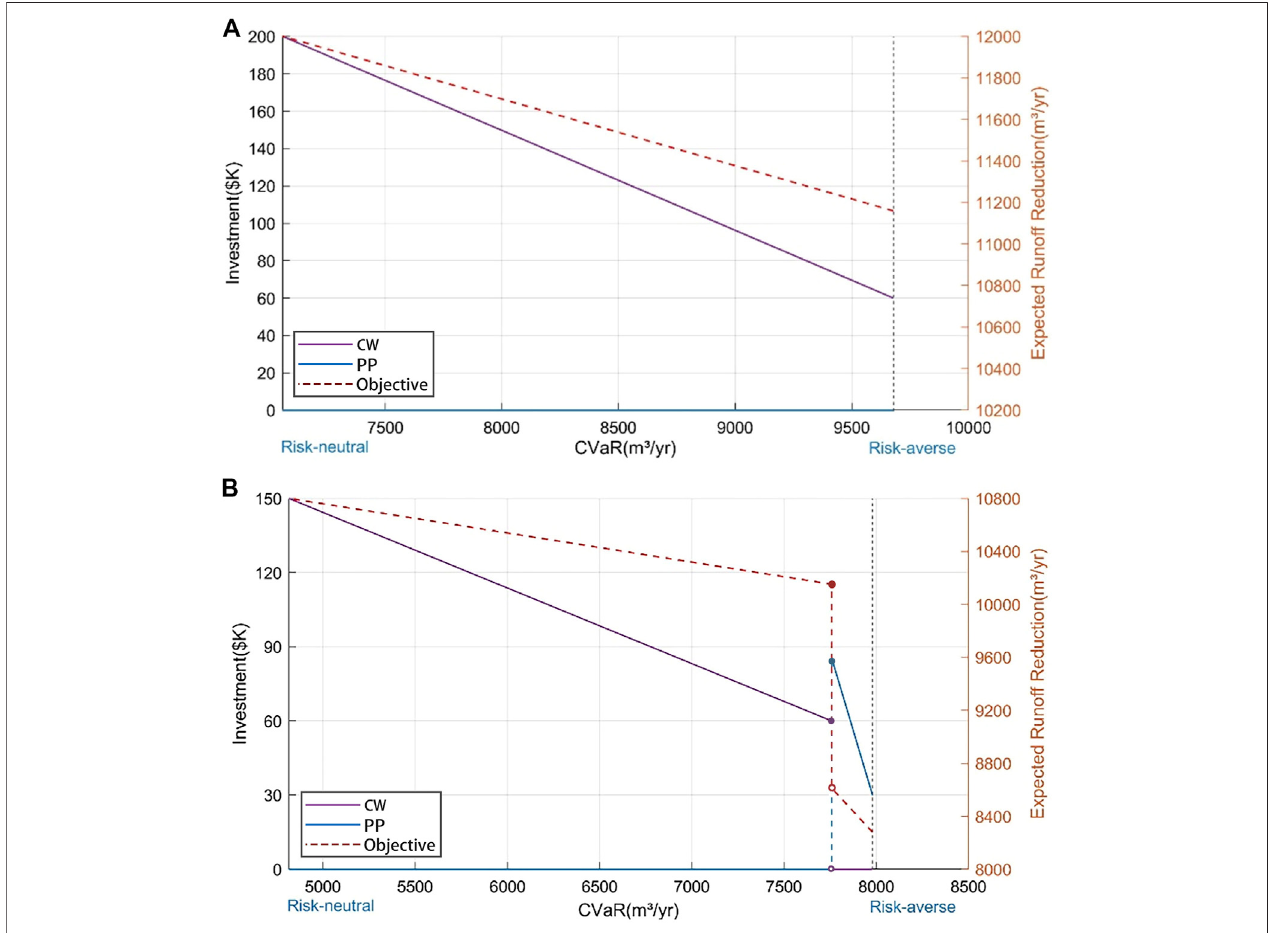
FIGURE 7 | Investment strategies at Stage I (left axis) and the objective function values (right axis) from the VL model for CVaR0.05 in (A) S01 and (B) S02.